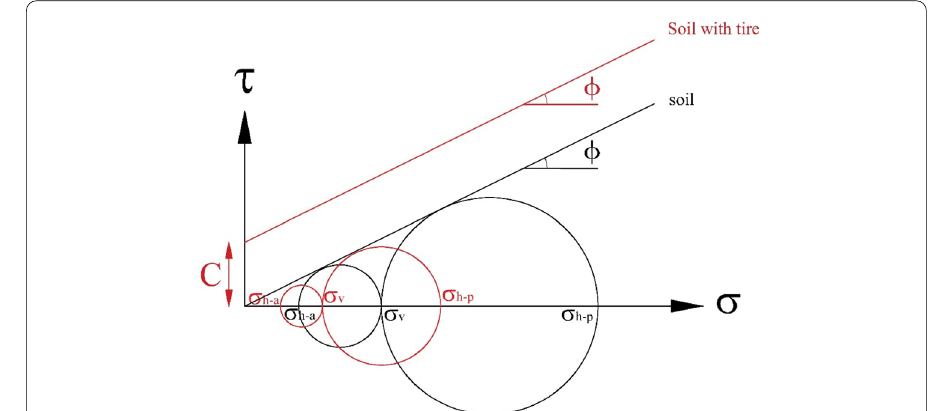
Fig. 12 Stress-state and failure criterion for mixed and unmixed area